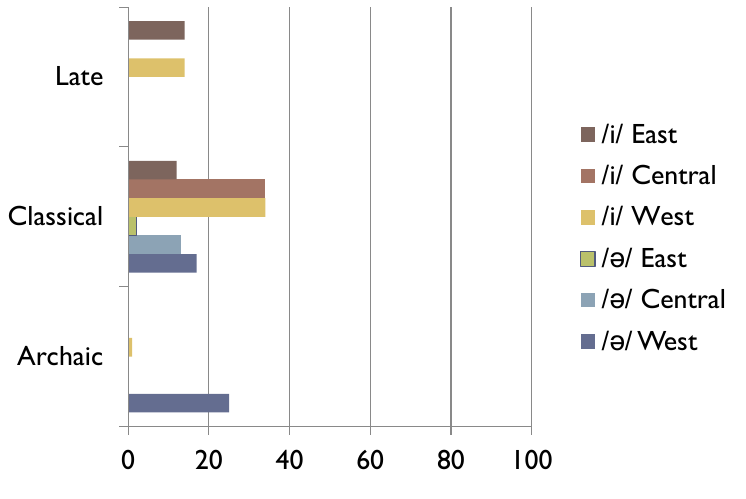
Figure 3: Attestations of raised TB ñiś and non-raised TB ñǝś according to regional distribution (absolute numbers)